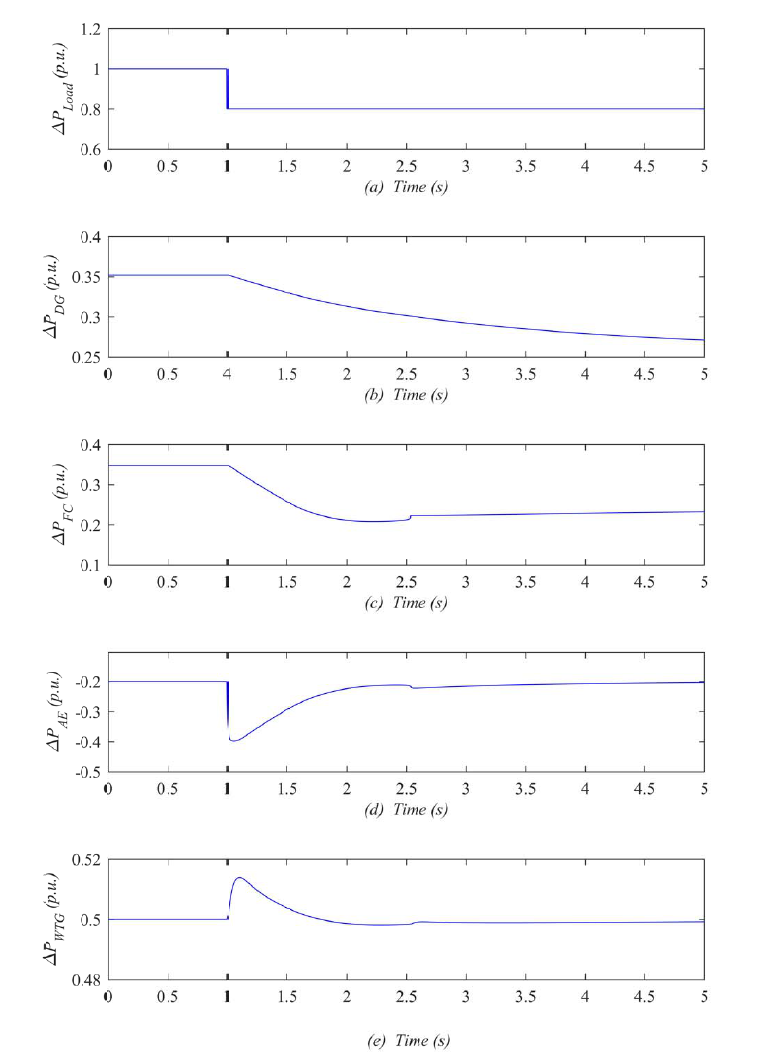
Figure 11. Transient power response of each energy sources with − 0.2 p.u. change of load demand based on ILADRC controller. ( a ) Load power change; ( b ) Dynamic response of DG; ( c ) Dynamic response of FC; ( d ) Dynamic response of AE; ( e ) Dynamic response of WTG.